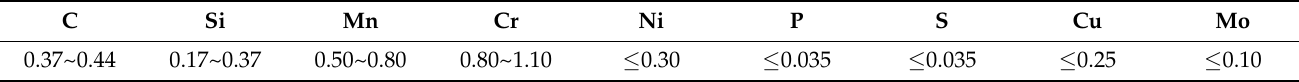
Table 2. The chemical composition of the 40 Cr.